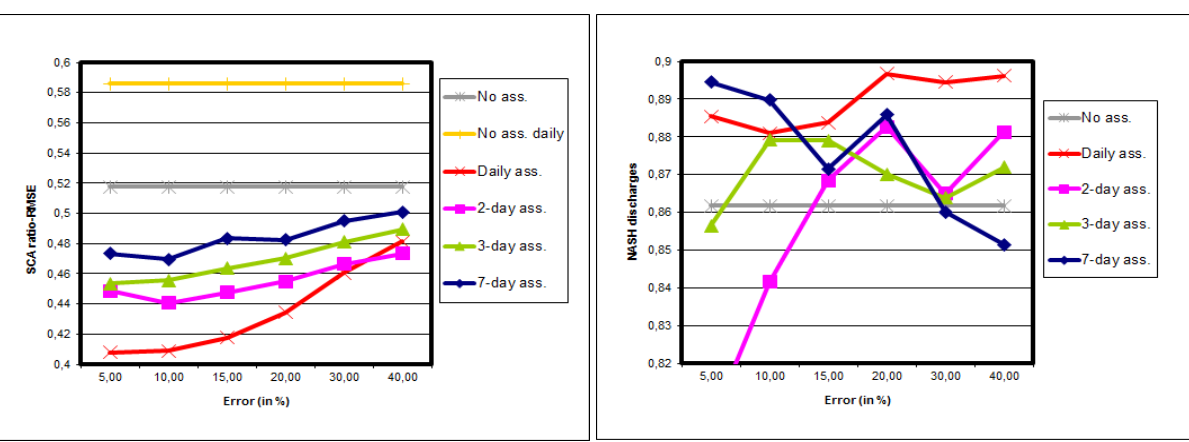
Figure 6. SCA ratio-RMSE ( left ) and Nash ( right ) for the real MODIS SCA particle filter experiments on the area upstream of the Kromericz station with 200 particles. The SCA proxy (not plotted) has a ratio-RMSE of 0.51 compared with the composite MODIS and 0.50 compared with the daily MODIS; the proxy discharges have a Nash of